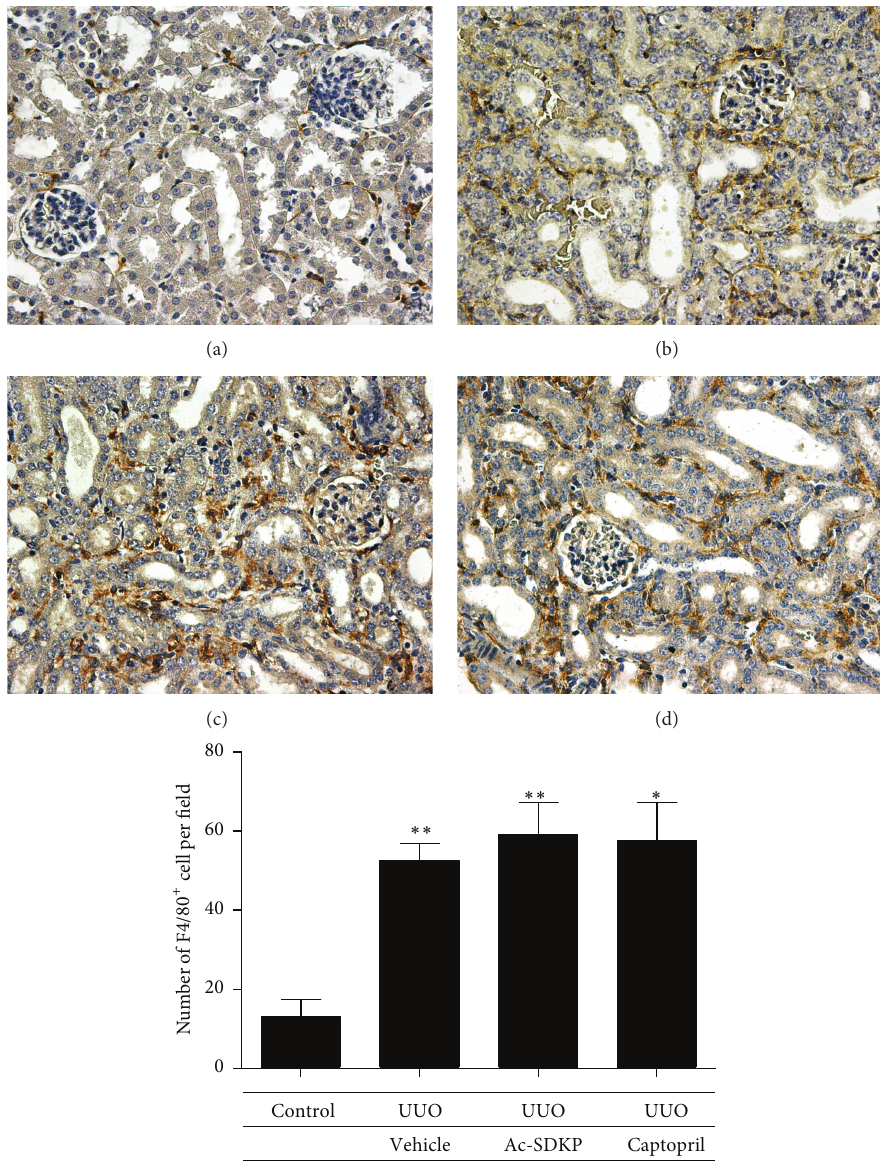
Figure 3: Macrophage infiltration. (a–d) F4/80+ve cells at day 7 of control animals (a), UUO operated animals (b), UUO animals with Ac- SDKP treatment (c), and UUO animals with Captopril treatment (d). Magnification (400x). (e) F4/80+ve cells counted from 10 randomly selected